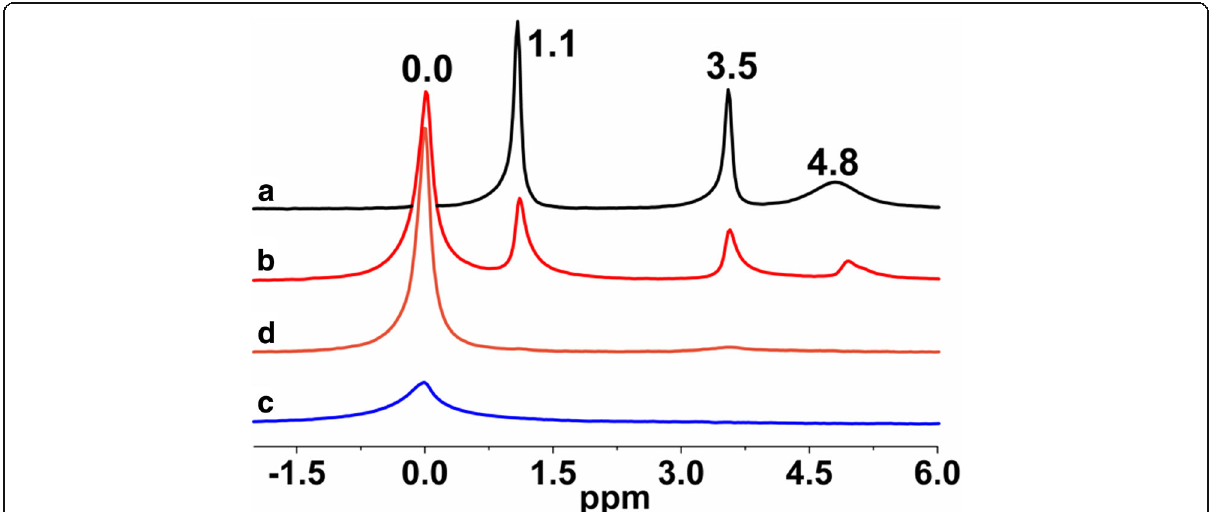
Fig. 10 1 H MAS NMR spectra of ( a ) neat fumed silica, ( b ) modified fumed silica with PDMS, modified with ( c ) mixtures of PDMS and dimethyl